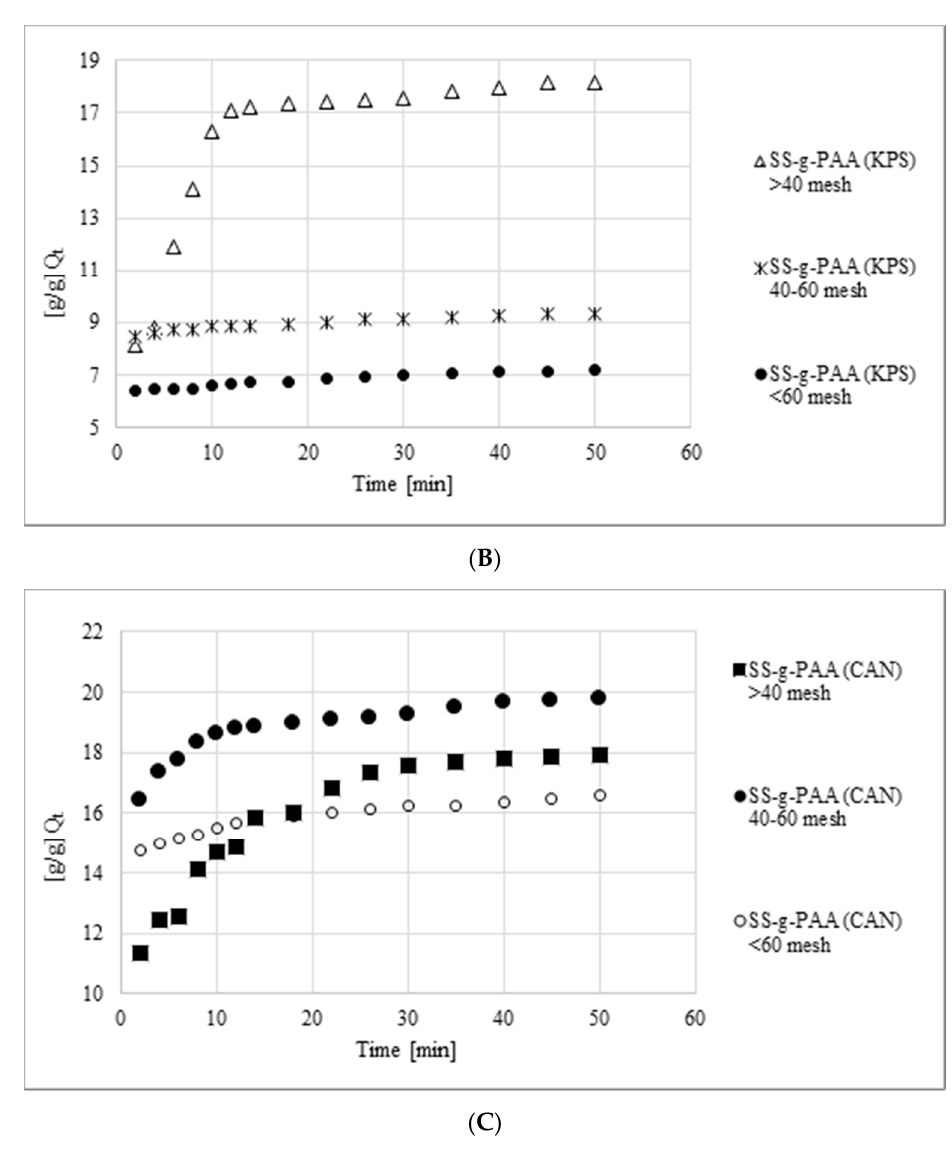
Figure 5. Swelling capacity of superabsorbents in 0.9 wt% NaCl aq solution ( A ) percentage of gel in all samples, ( B ) saline absorbency of samples prepared with potassium persulfate in a given time for different grain sizes, ( C ) saline absorbency of samples prepared with ceric ammonium nitrate in a given time for different grain sizes.